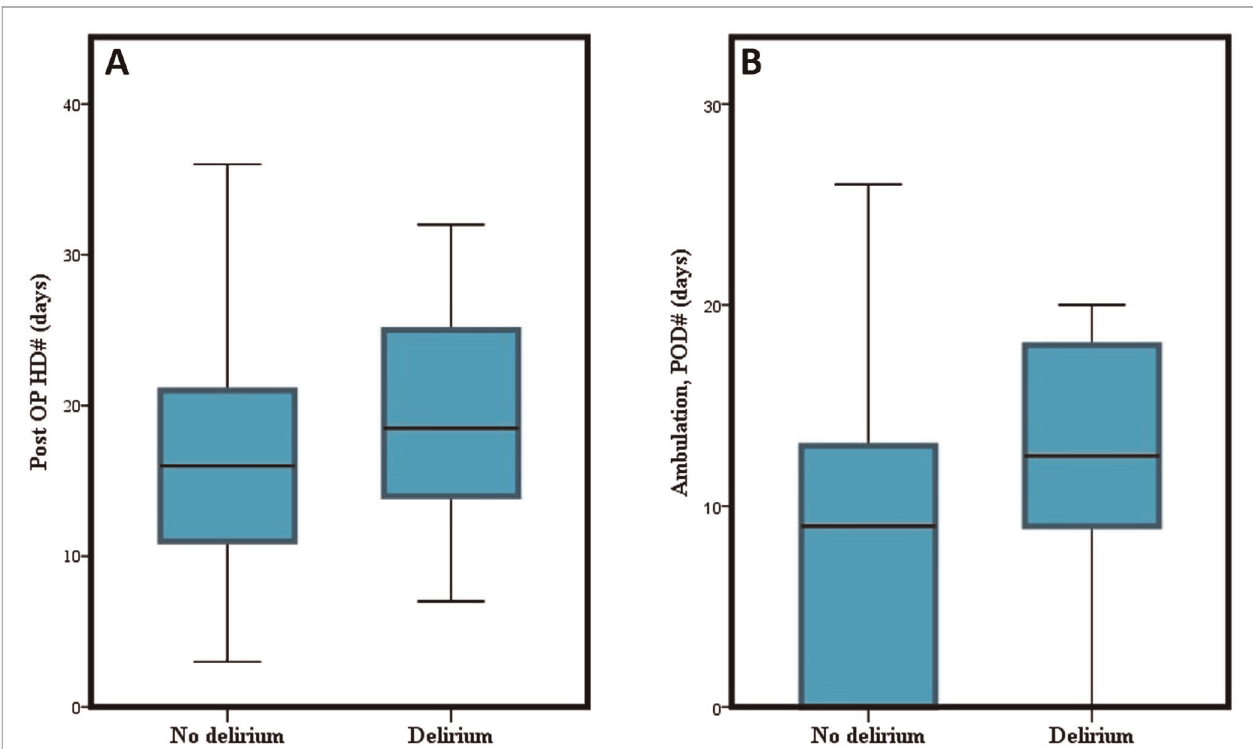
FIGURE 2 | Graphical depiction of the difference of ( A ) postoperative hospital days, and ( B ) initiation of ambulation between delirium and non-delirium